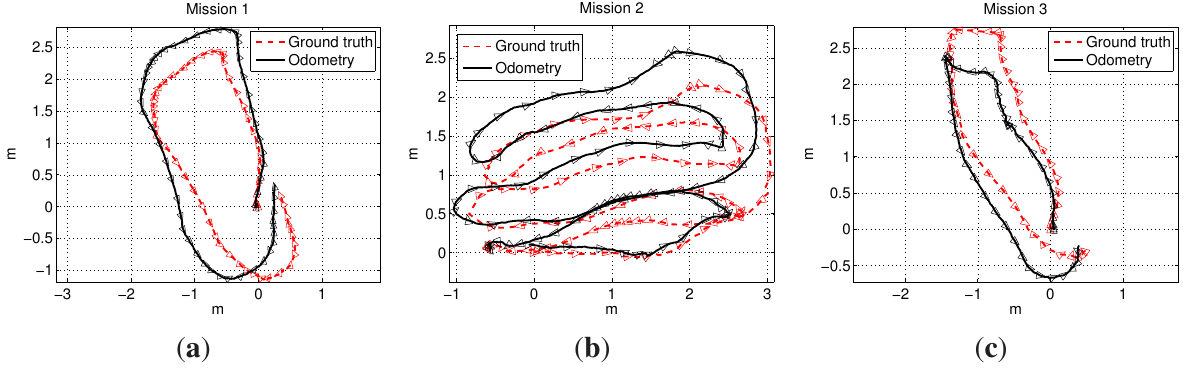
Figure 11. Ground truth and odometry corresponding to: ( a ) the first mission; ( b ) the second mission; and ( c ) the third